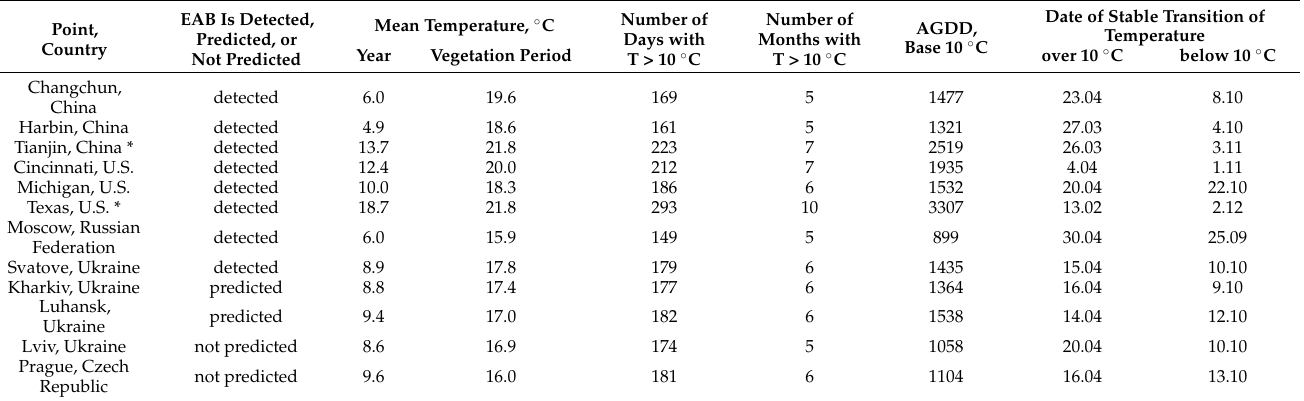
Table 5. Climatic indicators for several points where EAB was detected, predicted, or not